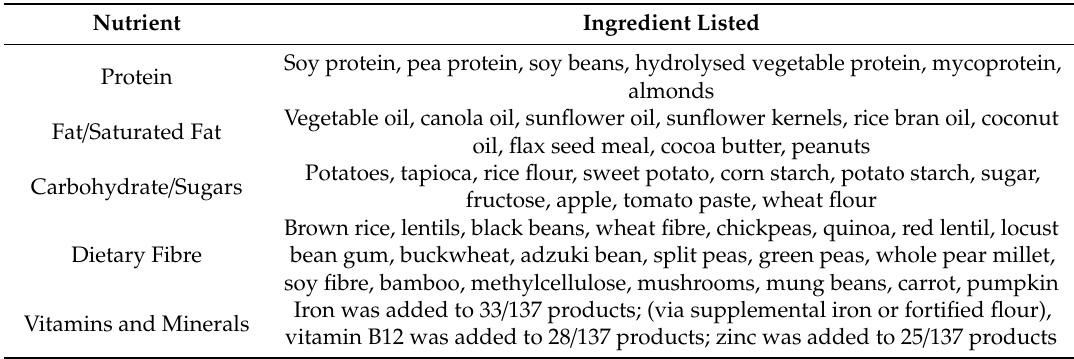
Table 5. Ingredients in plant-based meats contributing to key